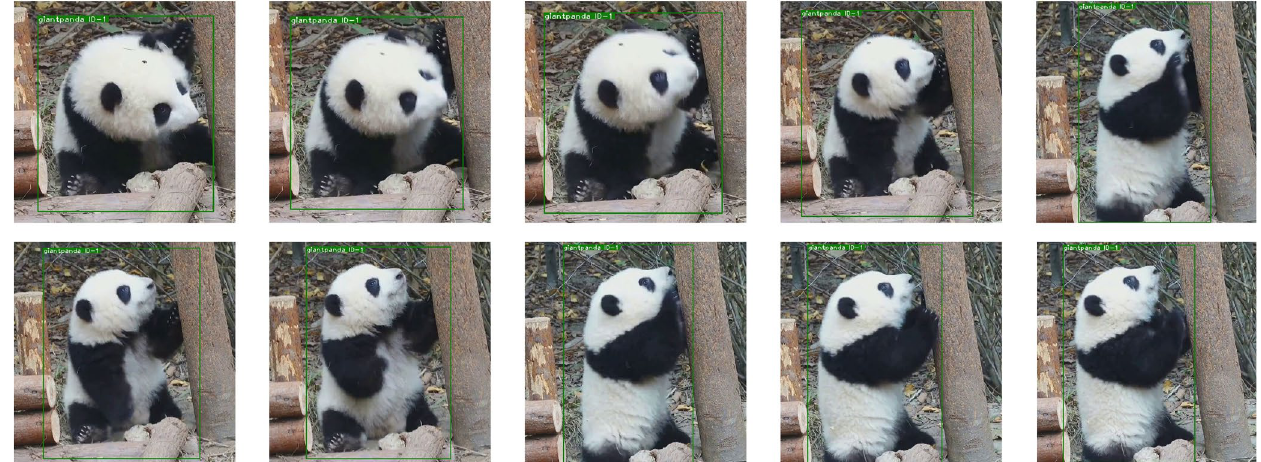
Figure 8. Tracking example of a giant panda.